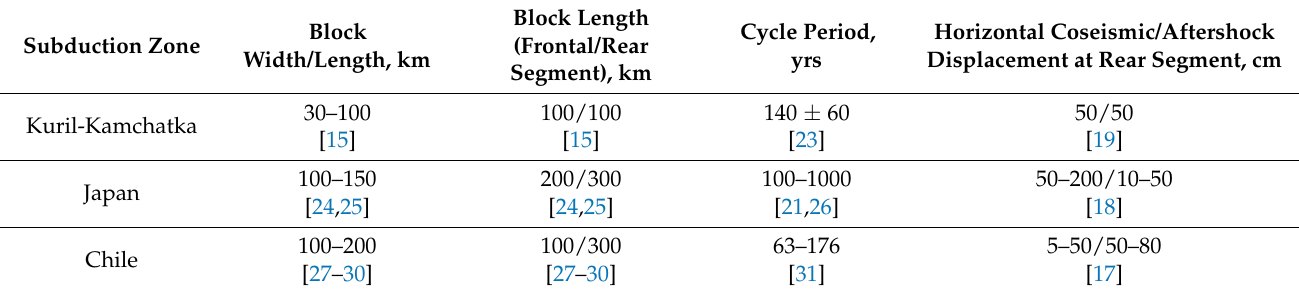
Table 1. Main characteristics of the structure and seismic cycle in Kuril-Kamchatka, Japan, and Chile subduction zones, according to our studies and available data.